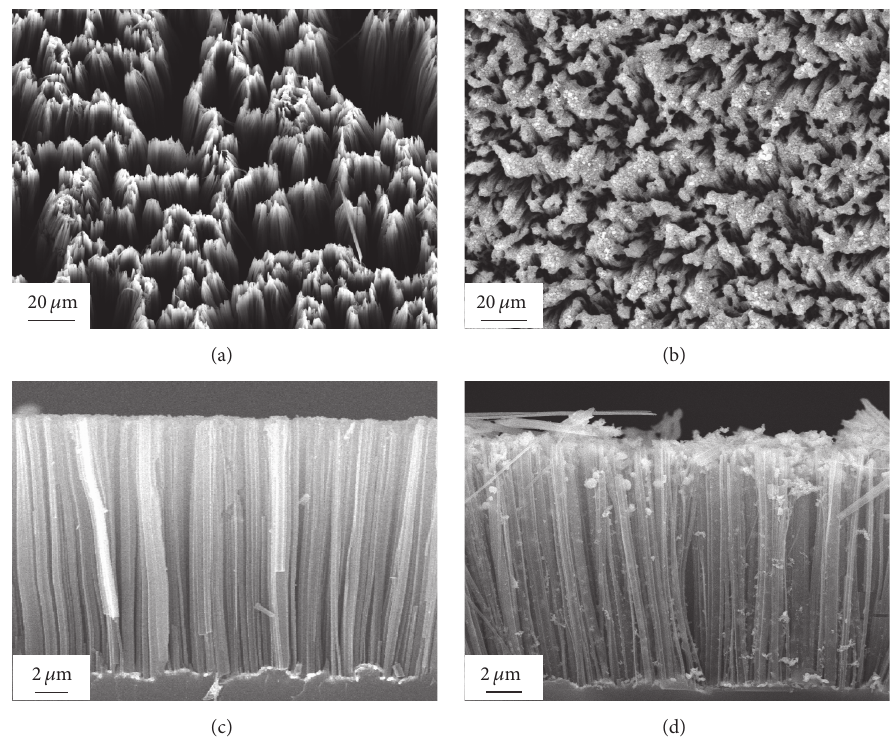
Figure 1: FE-SEM images of a top view and cross-sectional side view of the SiNWA (a), (c); top view and cross-sectional side view of the Ag/SiNWA (b), (d).